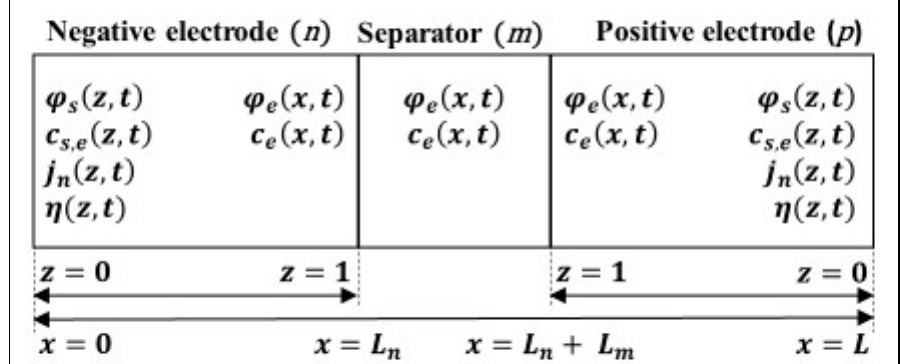
Figure 1. Three region cell model illustrating variables and their positions [12].